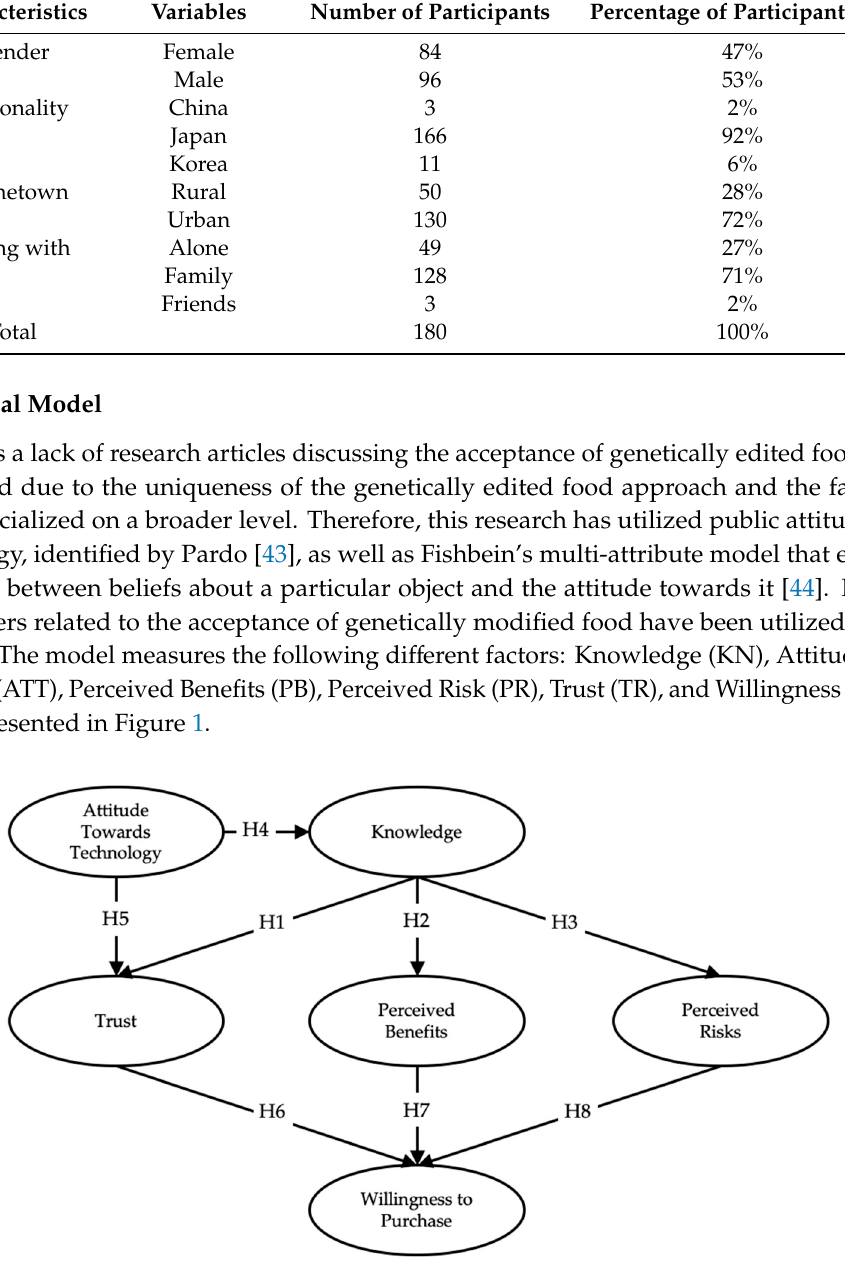
Figure 1. Model to be tested for hypotheses (H).